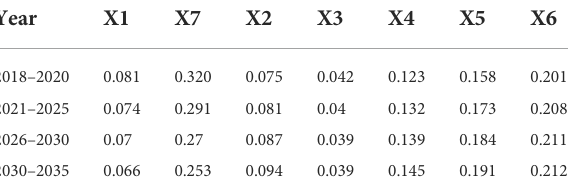
TABLE 6 Change trend of China ’ s industrial structure from 2018 to 2035.